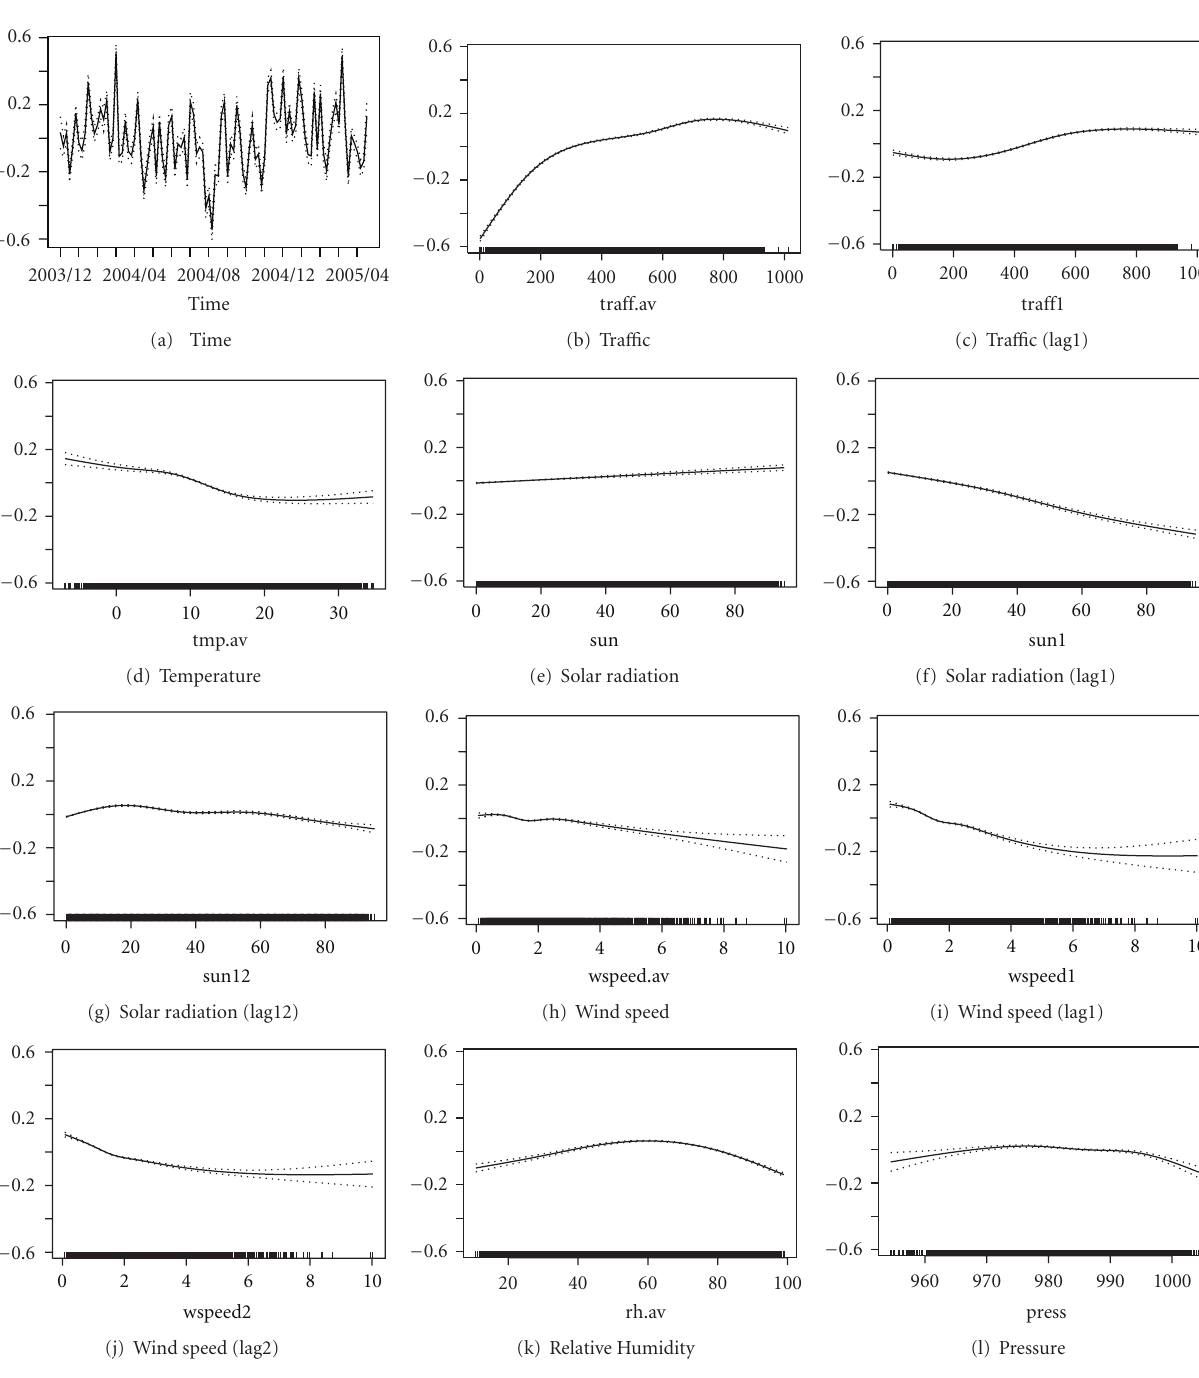
Figure 6: Estimated e ff ects of tra ffi c and meteorological variables for NO 2